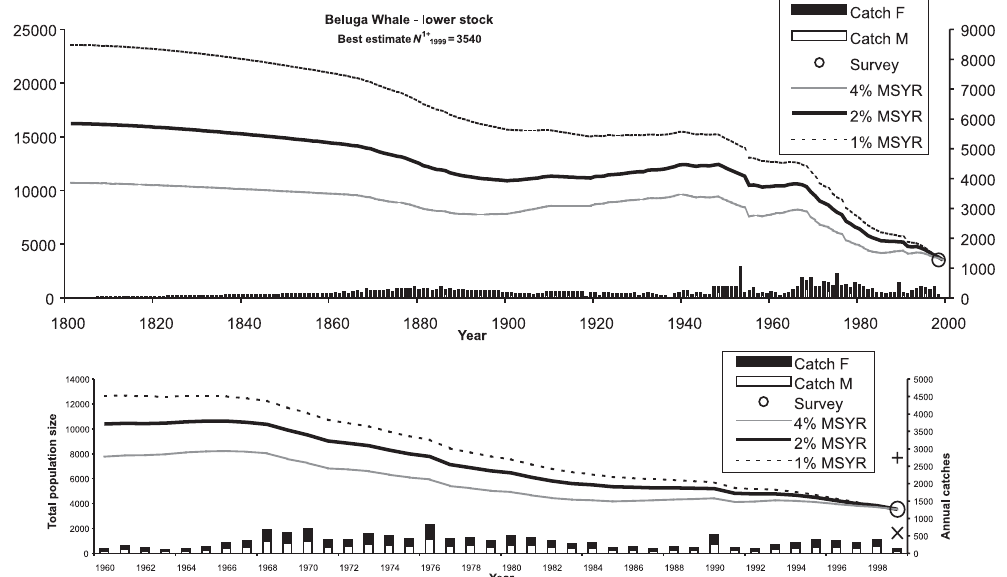
when hitting the 1999 best estimate of population size of 3,540 for MSYR 1+ values of 1%, 2% and 4%. The second vertical axis shows the annual catches over this period. The lower figure is a magni- fied version of the top figure and shows the best estimate of 1999 abundance with 90% confidence intervals.